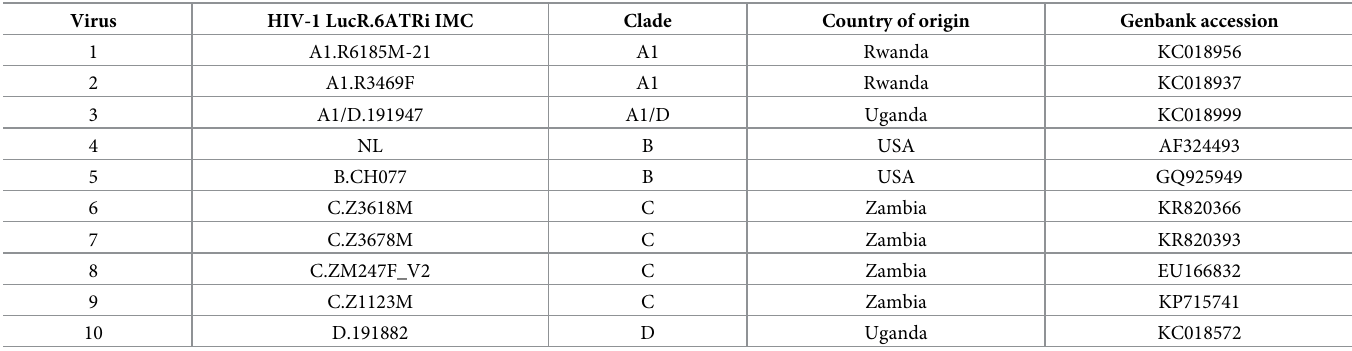
Table 3. Details of LucR.6ATRi IMC reporter viruses tested in the viral inhibition assay.